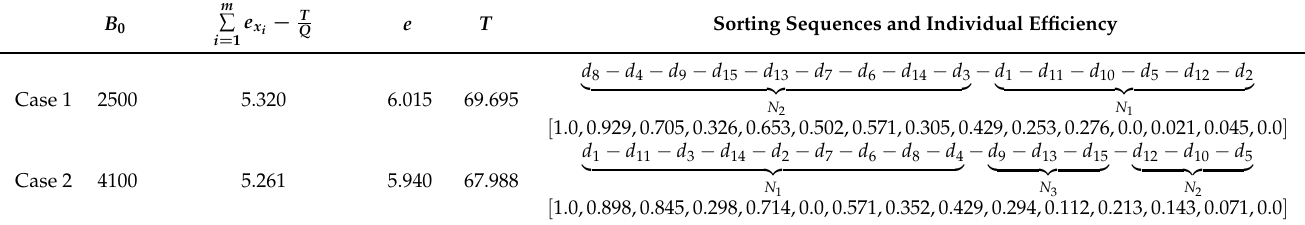
Table A10. Solutions of sorted negotiation Model (26) ( p = 0.95, q = 0.95, Q = 100). Sorting Sequences and Individual